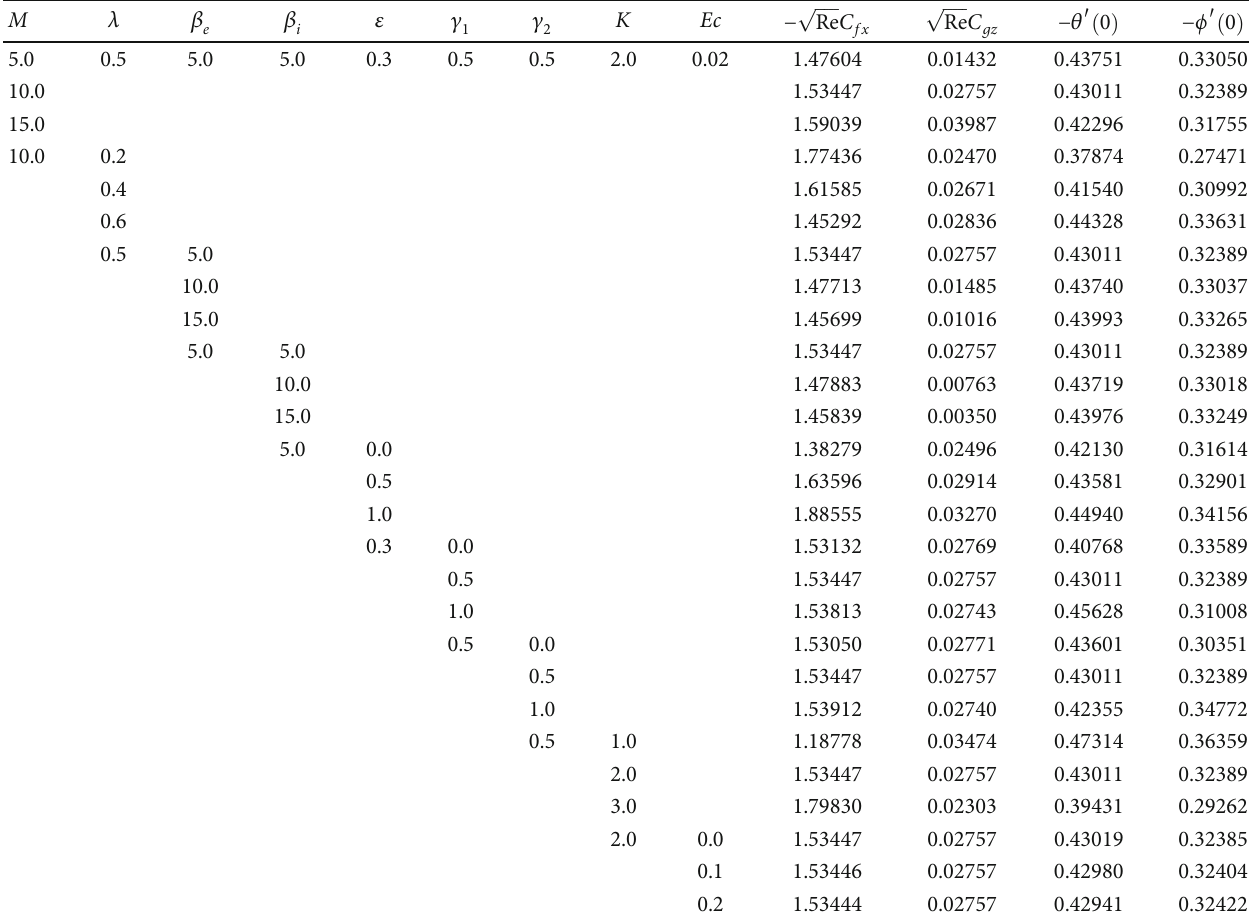
Table 2: Numerical values of the skin friction coe ffi